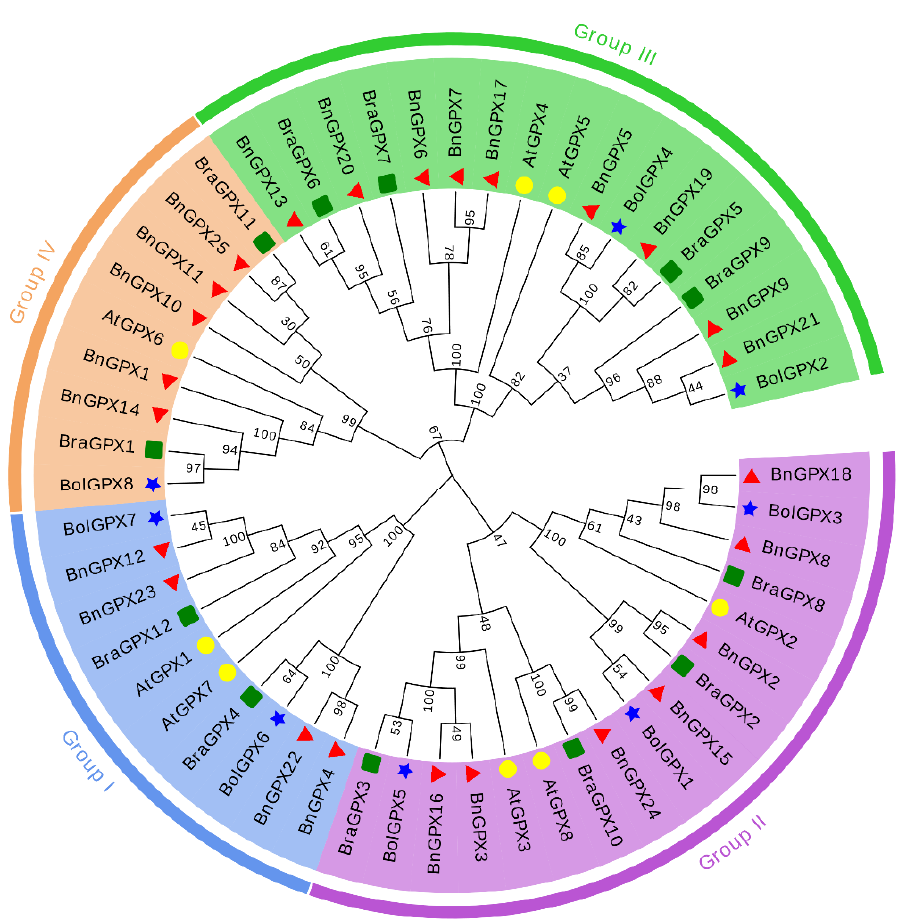
Figure 1. A neighbor-joining phylogenetic tree assessment of GPX genes in Brassica napus , Brassica oleracea , Brassica rapa , and Arabidopsis thaliana. Overall, 25 BnGPXs from Brassica napus (red triangle), 8 BolGPXs from Brassica oleracea (blue star), 12 BraGPXs from Brassica rapa (green box), and 8 AtGPXs from Arabidopsis thaliana (yellow circles) were clustered into four groups (Groups I–IV), symbolized by unique colors.